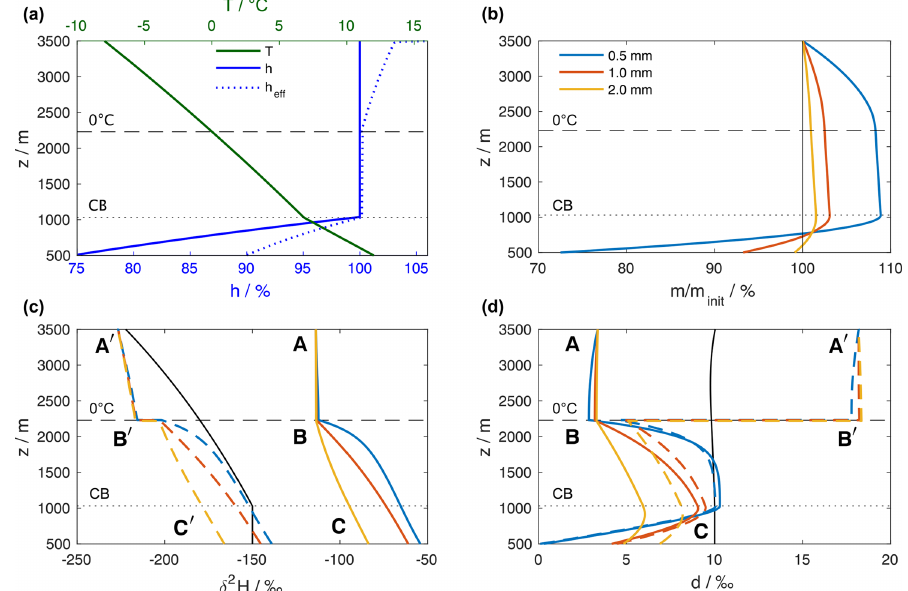
Figure 4. Results of the reference simulation of the single-column model. (a) Vertical profiles of air temperature (green line) and relative humidity over liquid (solid blue line), obtained from the (moist) adiabatic ascent of an air parcel from the surface with initial T 0 = 12 ◦ C and h 0 = 75%. The relative humidity of the surrounding air with respect to the temperature of the 1mm hydrometeor, denoted as effective relative humidity h eff , is shown as dotted blue line. (b) Hydrometeor mass relative to the initial mass at the formation height. The coloured lines correspond to three hydrometeors that arrive at the surface with an equivalent liquid diameter of 0.5, 1, and 2mm, respectively. (c) Iso- topic composition of hydrometeors and the surrounding vapour. Coloured lines show the isotopic composition of the hydrometeors ( δ 2 H p , solid) and the equilibrium vapour from the hydrometeors ( δ 2 H p , eq , dashed). The black line indicates the composition of the ambient vapour ( δ 2 H v ). The letters mark locations that are referenced in the text. (d) Same as (c) but for d p and d p , eq . Horizontal dashed and dotted black lines in all plots mark the height of the 0 ◦ C isotherm and the height of the cloud base (CB),